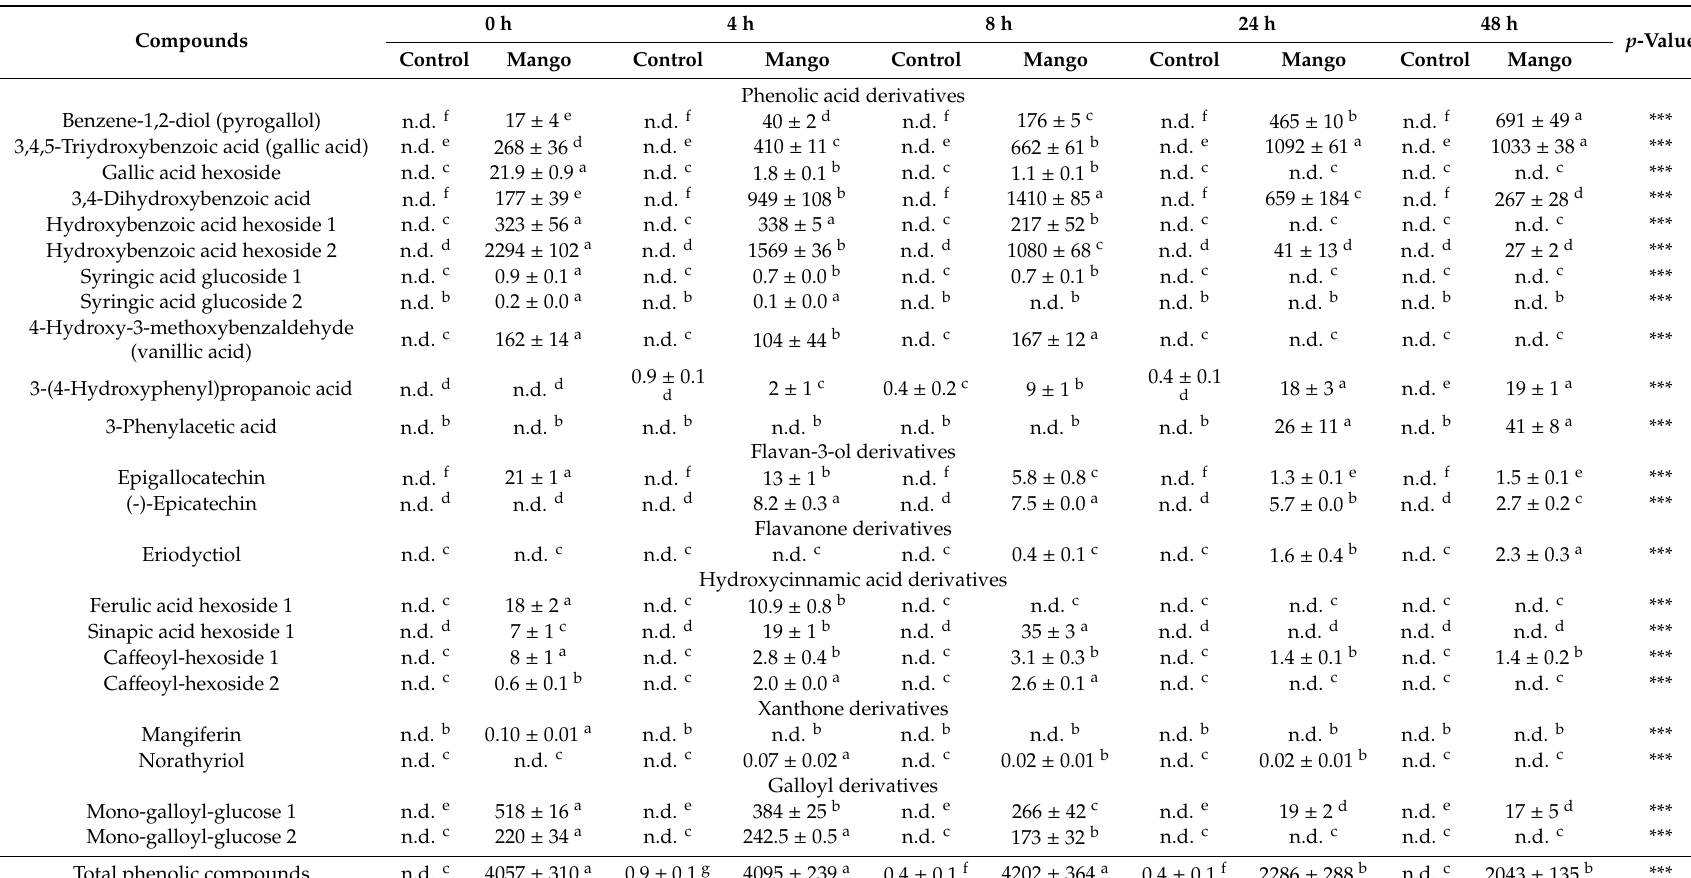
Table 4. Stability of native mango polyphenols and catabolites produced during 0, 4, 8, 24 and 48 h of faecal fermentation. Results are expressed as mean ± standard deviation ( µ mol / g DW) ( n =